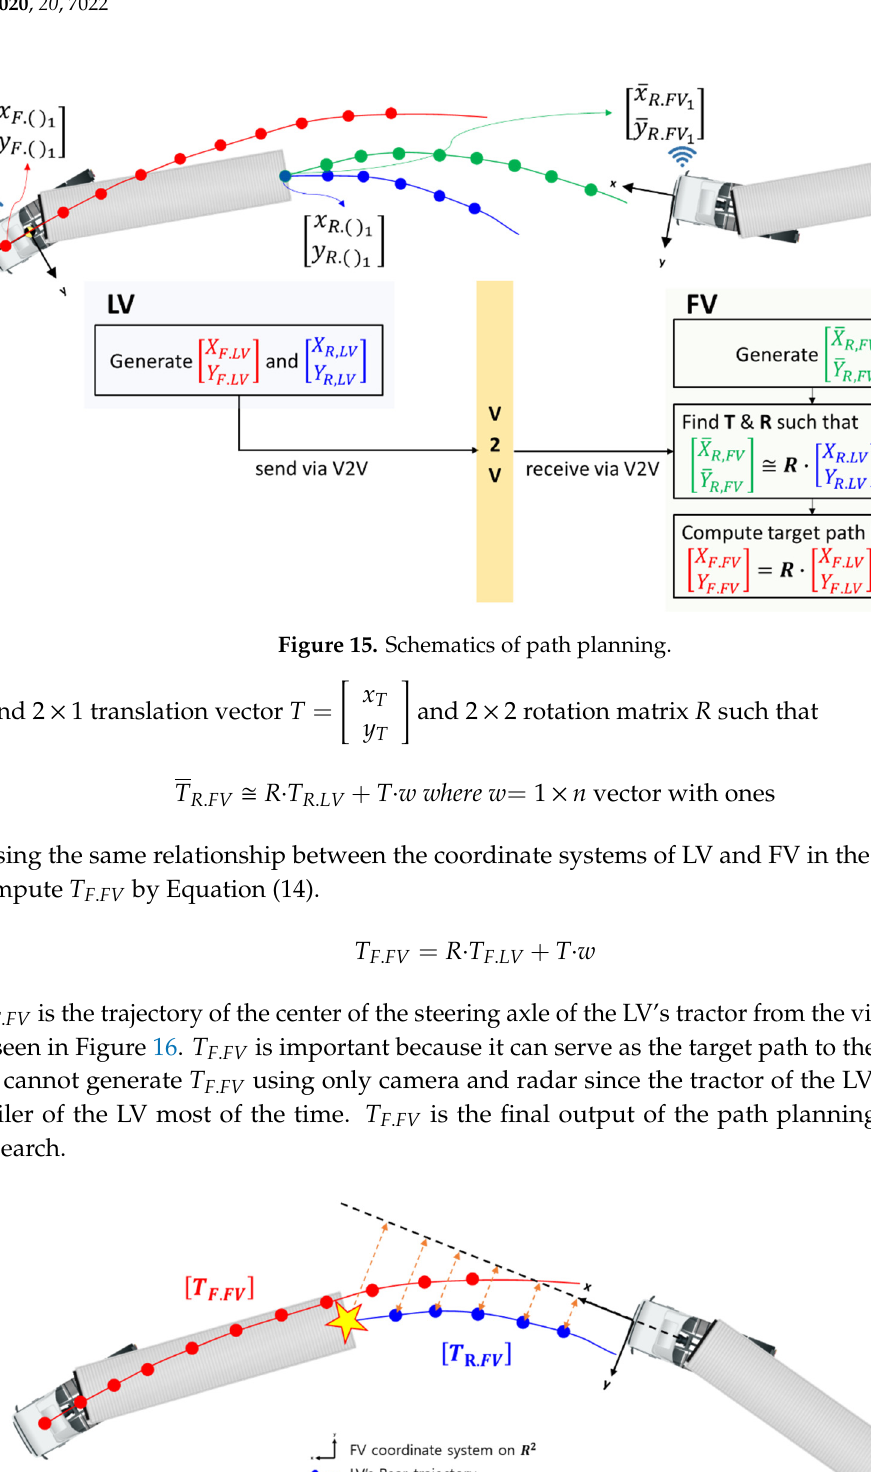
Figure 17. Reference point matching before finding the rotational relationship. In the study, the Kabsch algorithm [24,25] was adopted to find the optimal rotation matrix after the reference point matching. The Kabsch algorithm is a method to compute the optimal rotation matrix by minimizing the RMSD (Root Mean Squared Deviation) between the two datasets to be matched. This algorithm is used to convert the LV’s trajectory received by V2V communication into the FV’s coordinate system, and it is explained below in the context of path planning. First, Equation (15) shows the two datasets and their reference points. 𝑃 = 𝑇 (cid:3019).(cid:3013)(cid:3023) = (cid:3428)𝑋 (cid:3019),(cid:3013)(cid:3023) 𝑌 (cid:3019),(cid:3013)(cid:3023) (cid:3432) = (cid:4674)𝑥 (cid:3019).(cid:3013)(cid:3023) (cid:3117) 𝑥 (cid:3019).(cid:3013)(cid:3023) (cid:3118) ⋯ 𝑥 (cid:3019).(cid:3013)(cid:3023) (cid:3289) 𝑦 (cid:3019).(cid:3013)(cid:3023) (cid:3117) 𝑦 (cid:3019).(cid:3013)(cid:3023) (cid:3118) ⋯ 𝑦 (cid:3019).(cid:3013)(cid:3023) (cid:3289) (cid:4675) , 𝑝 (cid:2868) = (cid:4674)𝑥 (cid:3019).(cid:3013)(cid:3023) (cid:3117) 𝑦 (cid:3019).(cid:3013)(cid:3023) (cid:3117) (cid:4675) : reference point of 𝑃 𝑄 = 𝑇(cid:3364) (cid:3019).(cid:3007)(cid:3023) = (cid:4680)𝑋(cid:3364) (cid:3019),(cid:3007)(cid:3023) 𝑌(cid:3364) (cid:3019),(cid:3007)(cid:3023) (cid:4681) = (cid:3428)𝑥̅ (cid:3019).(cid:3007)(cid:3023) (cid:3117) 𝑥̅ (cid:3019).(cid:3007)(cid:3023) (cid:3118) ⋯ 𝑥̅ (cid:3019).(cid:3007)(cid:3023) (cid:3289) 𝑦(cid:3364) (cid:3019).(cid:3007)(cid:3023) (cid:3117) 𝑦(cid:3364) (cid:3019).(cid:3007)(cid:3023) (cid:3118) ⋯ 𝑦(cid:3364) (cid:3019).(cid:3007)(cid:3023) (cid:3289) (cid:3432) , 𝑞 (cid:2868) = (cid:3428)𝑥̅ (cid:3019).(cid:3007)(cid:3023) (cid:3117) 𝑦(cid:3364) (cid:3019).(cid:3007)(cid:3023) (cid:3117) (cid:3432) : reference point of 𝑄